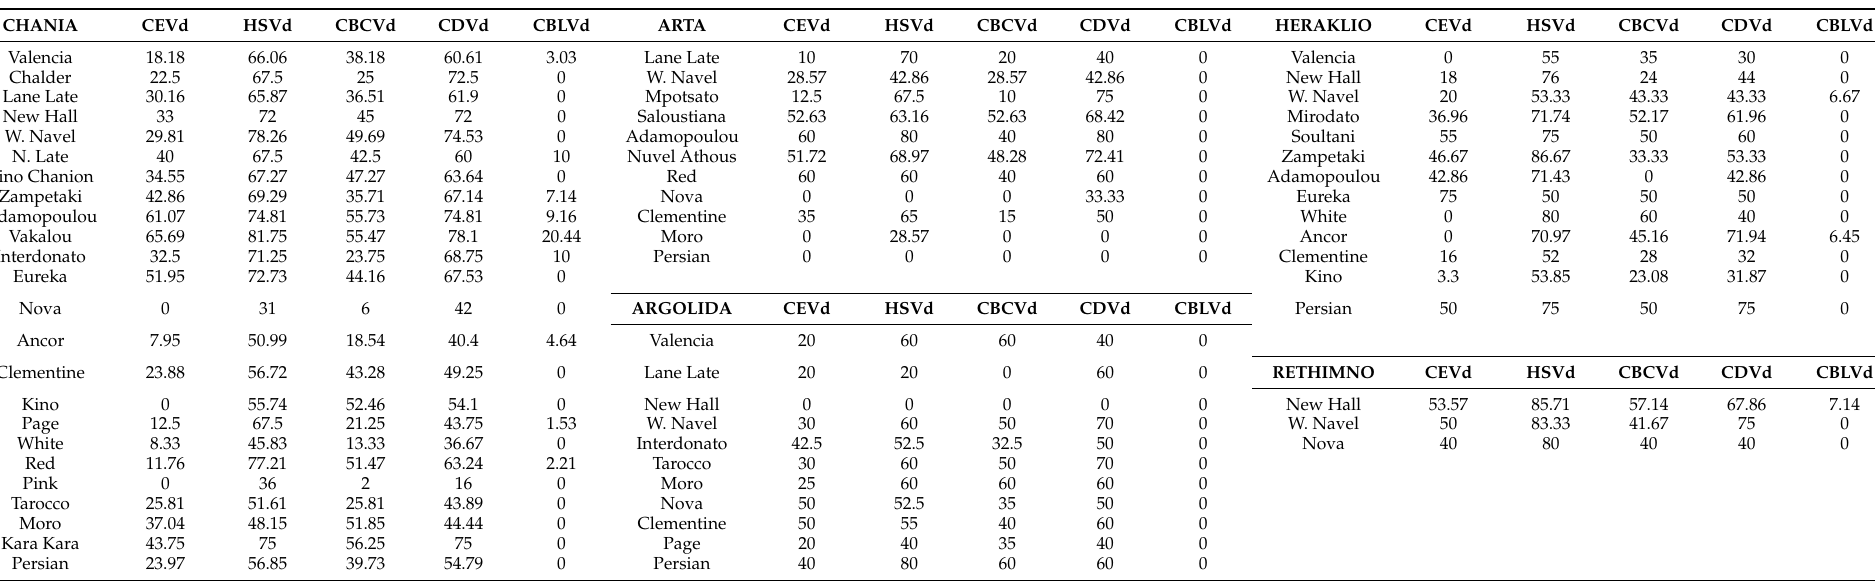
Table 1. Results of the conducted survey for frequency evaluation of citrus viroids in Greece. Results are presented as percentages (%) of the infected samples per host cultivar in each geographical